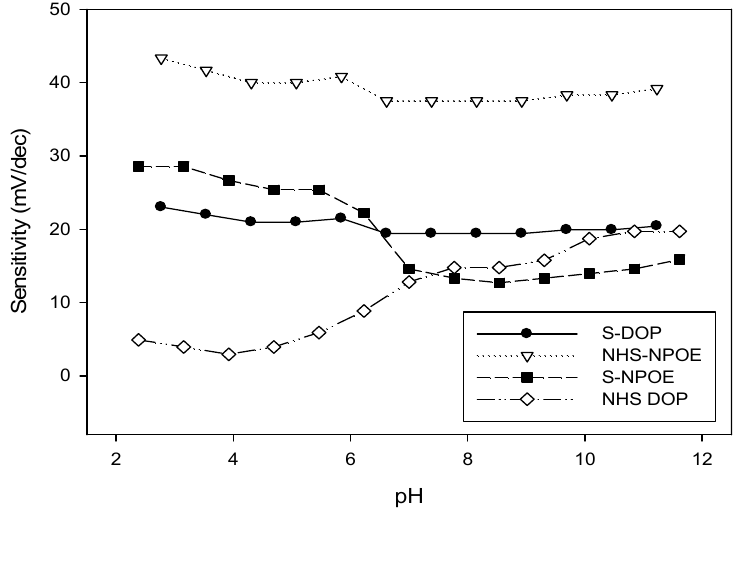
Figure 3. Effect of pH on the observed sensitivities for the four membranes evaluated.